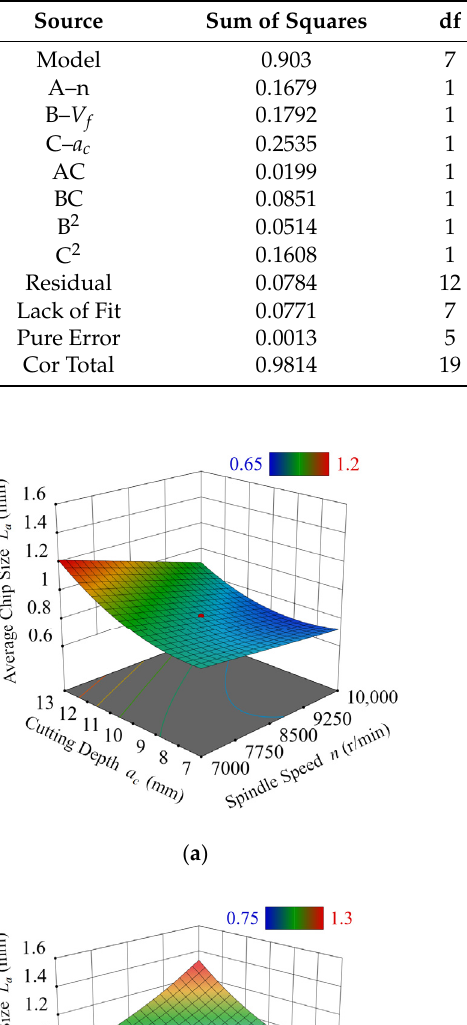
Table 6. The model’s R 2 value, adjusted R 2 value, and predicted R 2 value were determined to be 0.9201, 0.8735, and 0.6484, respectively, with an adeq precision value of 16.9314. The overall regression of the model is considered to be highly significant, with a p -value less than 0.0001. The F-value of 19.74 indicates that the probability of the model being influenced solely by noise is only 0.01. All variables included in the table are significant, with p < 0.05 indicating high significance, 0.1 < p < 0.05 indicating significance, and p > 0.1 signifying insignificance.